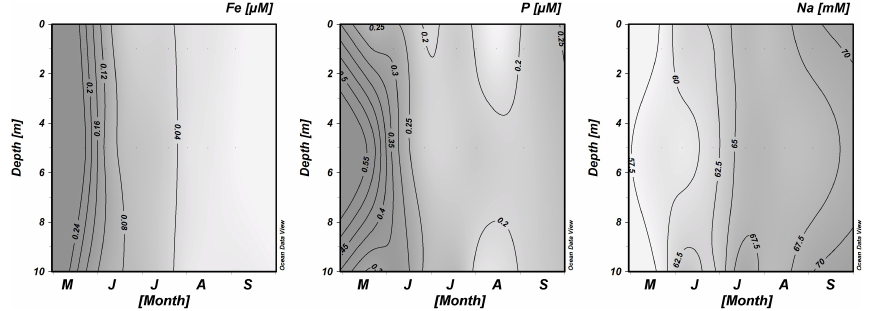
Fig. 5. Variations of total Fe (unfiltered samples), phosphorus (P) and sodium (Na) for the uppermost 10m at the Bothnian Sea station 2006. Date format is decimal year. This figure was prepared with Ocean Data View using DIVA gridding. for samples taken at 0.5, 5 and 10m